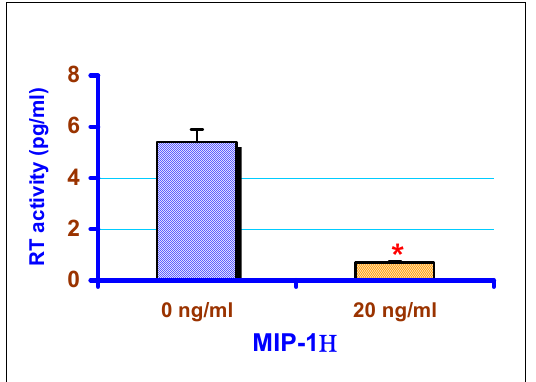
Figure 4. Exogenous rHu MIP-1 α decreases RT activity of CAEV in vitro . CAEV replication was assessed by measuring RT activity present in the GSM cell culture supernatants. Supernatants were collected 72 h post-infection for RT analysis. Mean RT value of MIP-1 α treated cell culture supernatant was 0.7 ng/ml compared to that of 5.4 ng/ml of control (no chemokine added) sample. *indicates significant difference from control (P ≤ 0.01).